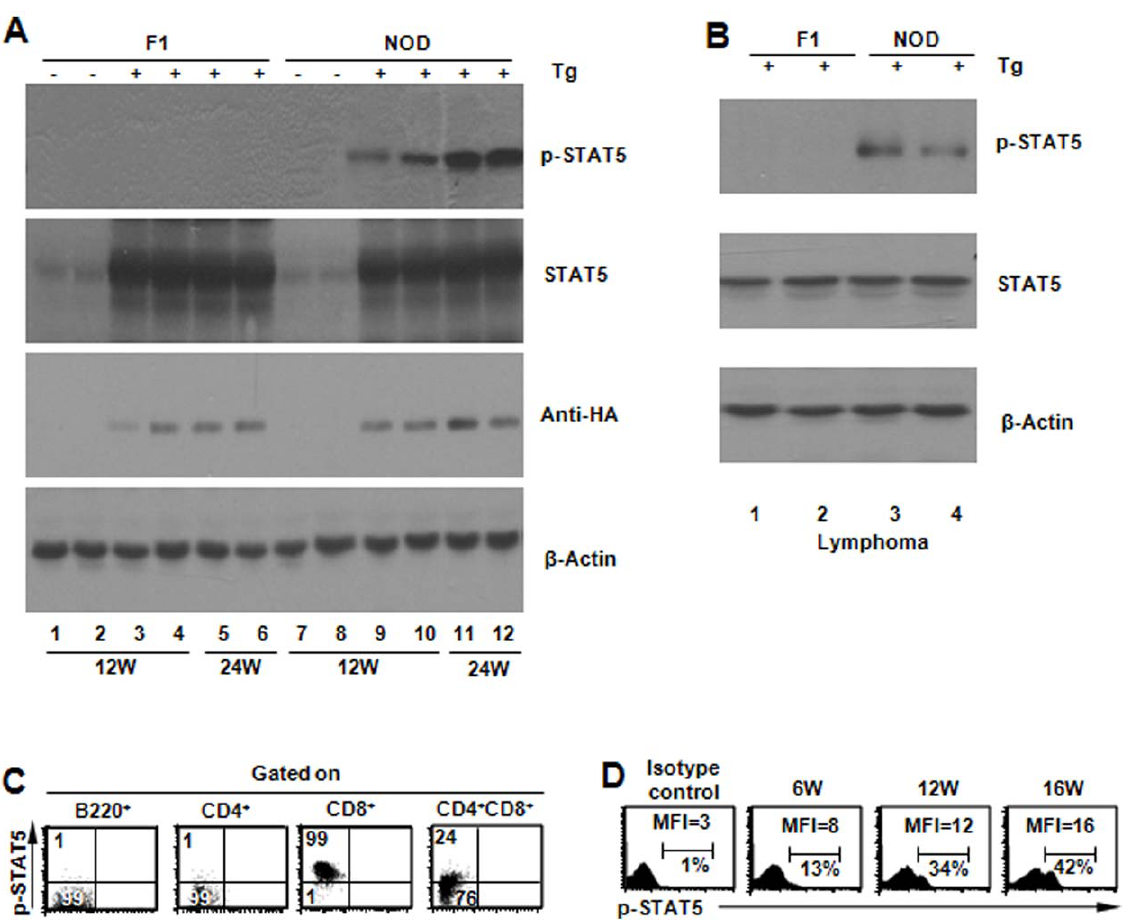
Figure 3. STAT5 phosphorylation in Stat5b transgenic mice. (A) Representative Western blotting analysis for phosphorylated and total STAT5 in F1 and NOD Stat5b transgenic lines. These mice did not have detectable signs of lymphoma based on physical examination and FACS analysis of T cell phenotypes. Protein extracts from thymus were used for the experiment. (B) Representative Western blotting analysis of phosphorylated STAT5 with thymus protein extracts from NOD.Stat5b transgenic mice with lymphoma. (C) STAT5 phosphorylation status in different cell types. Thymocytes and splenocytes from NOD Stat5b Tg mice were analyzed by intracellular staining for phosphorylated STAT5 with an anti–pTyr694-STAT5 antibody. (D) FACS analysis showing progressive increase of STAT5 phosphorylation in thymocytes of NOD.Stat5b Tg mice. Data for thymus are shown here for 6, 12 and 16 week old NOD.Stat5b Tg mice (all without tumor). Representative data are shown from 1 of 3 similar experiments.